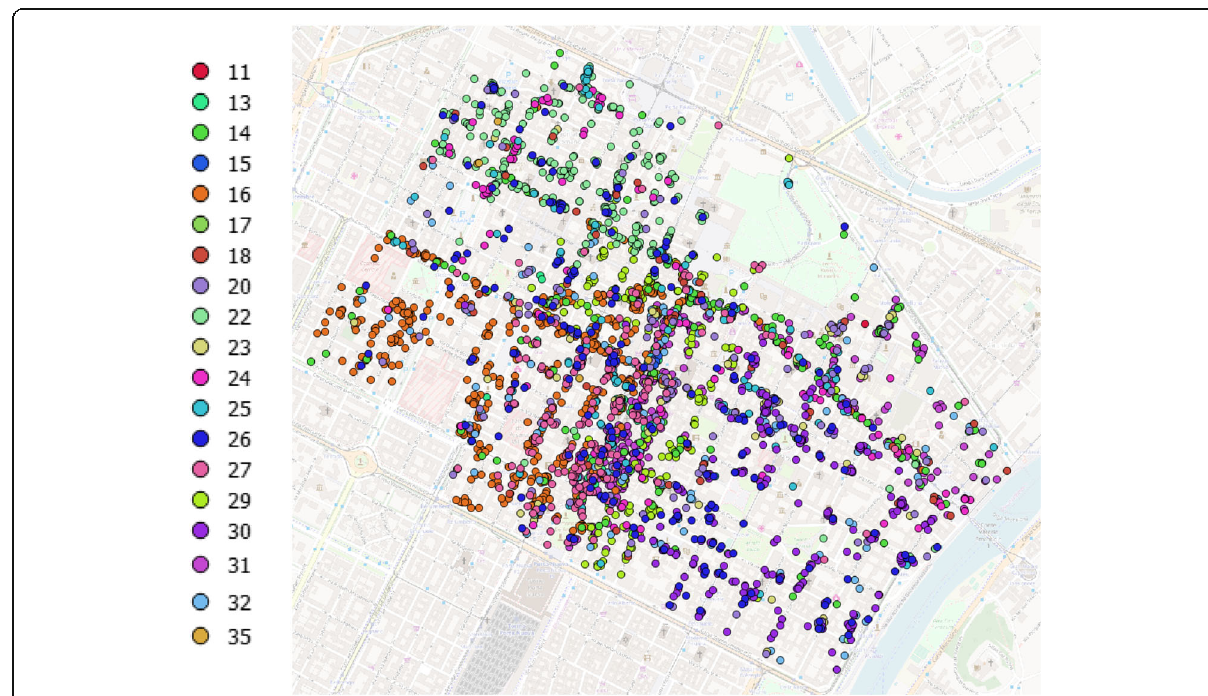
Fig. 1 Service stops of freight distribution vehicles in the Turin LTZ, May 2017: each color represents a different vehicle (vehicles IDs available on the left)